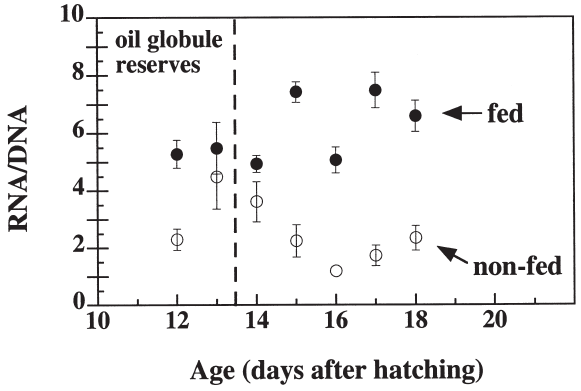
F IG . 5. – RNA/DNA ratios estimated in the feeding experiment con- ducted on Dicentrarchus labrax larvae. Vertical bars indicate the standard error of the mean. The shadow area corresponds to the days on which the oil globule was still present. Details in sections D and I.